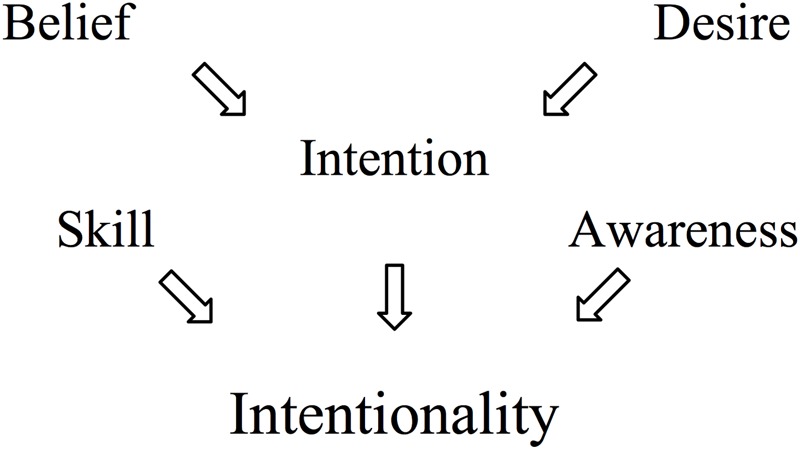
The constituents of the folk concept of intentionality. Adapted from Malle and Knobe (1997).